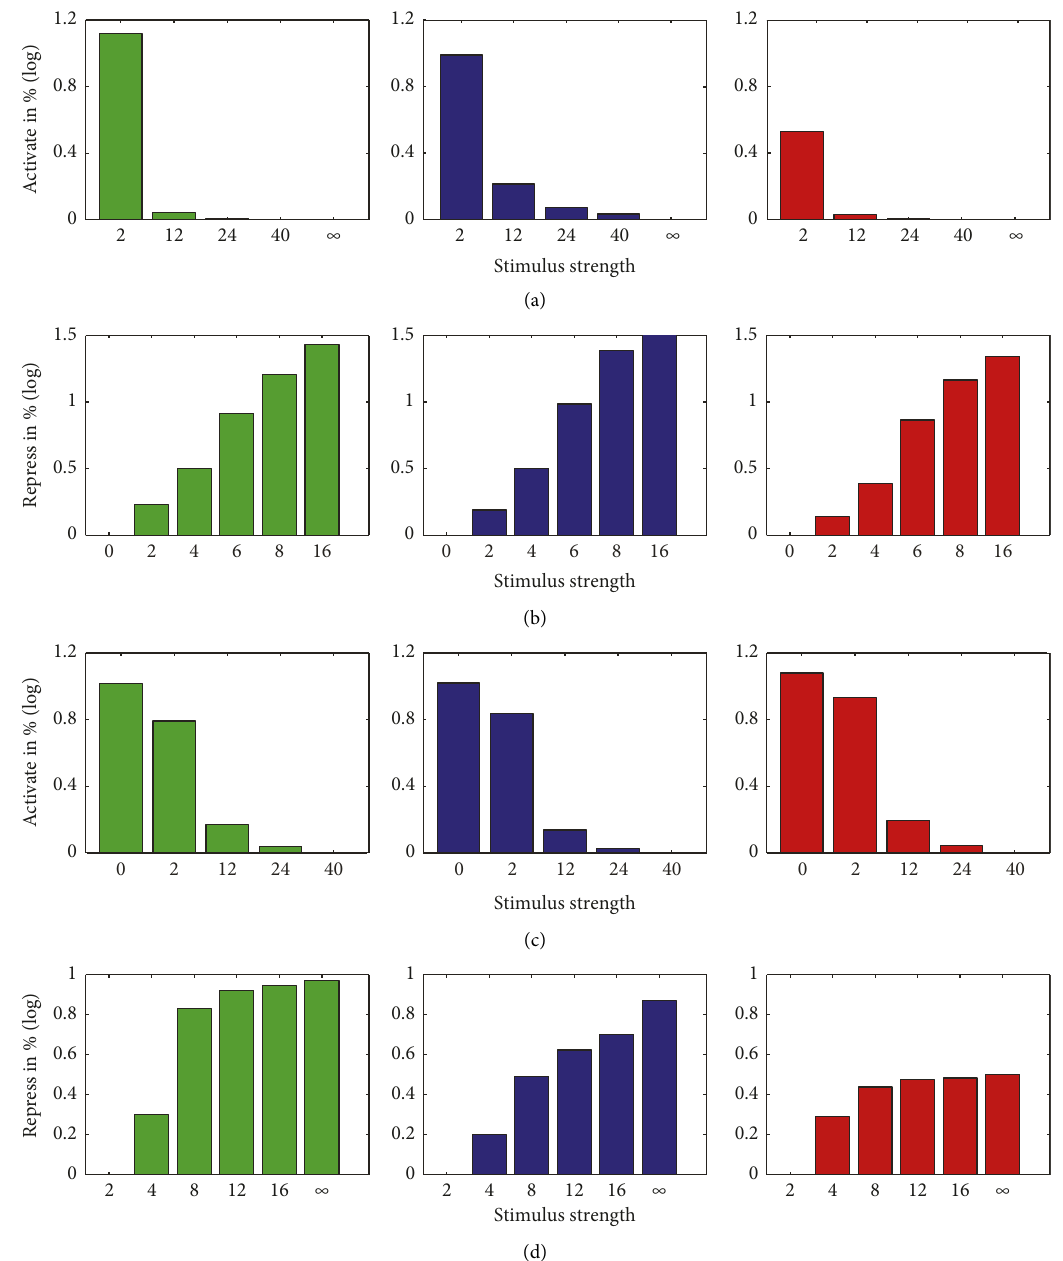
Figure 8: The changing trends of higher expression peaks under different paradigms: (a, b) FM paradigm; (c, d) AM paradigm; (a, c) activator; (b, d) repressor. The green drawing represents the upstream input as the frequency signal, the blue drawing represents the upstream input as the amplitude signal, and the red drawing represents the noiseless input. Other parameter values are set as k